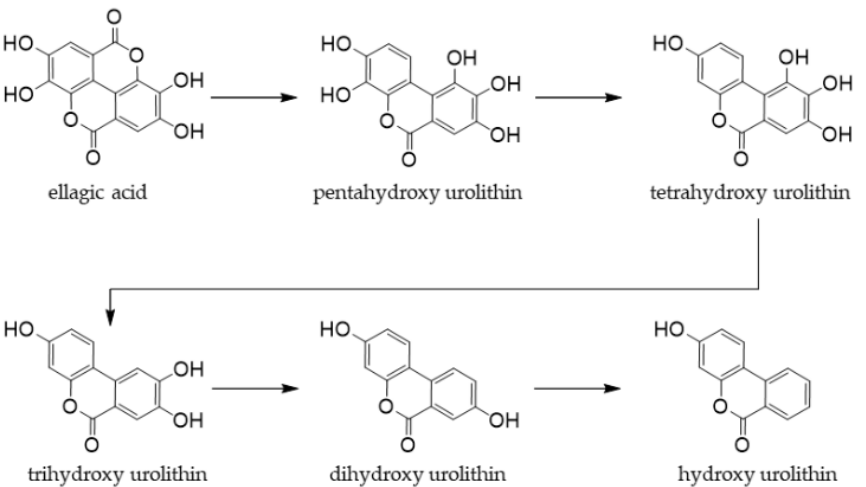
Figure 18. Schematic representation of the production of microbial metabolites from ellagic acid. Modified from [291].